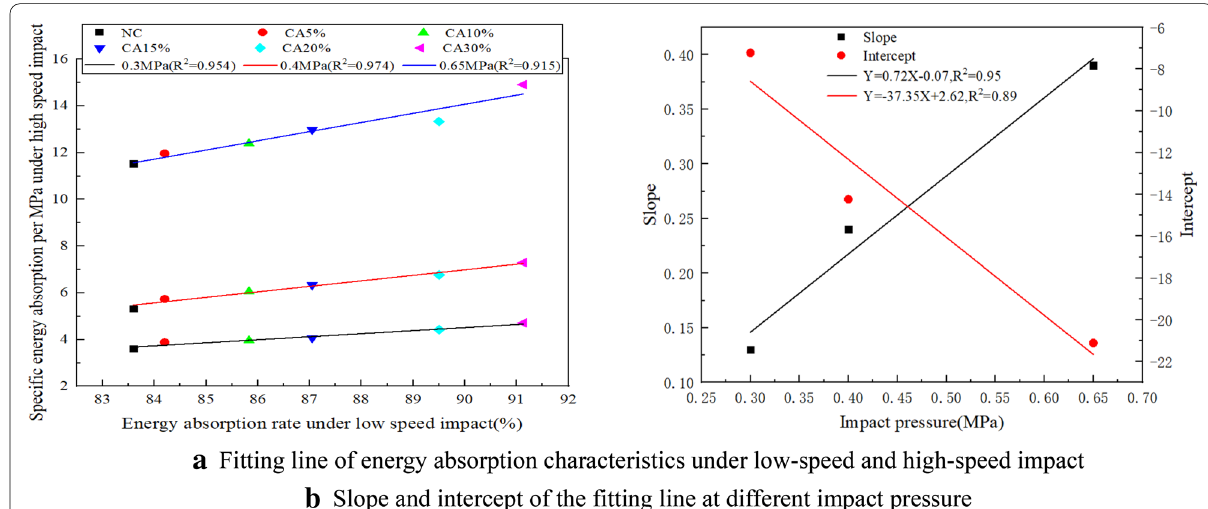
Fig. 18 Relationship between energy absorption characteristics under different impact